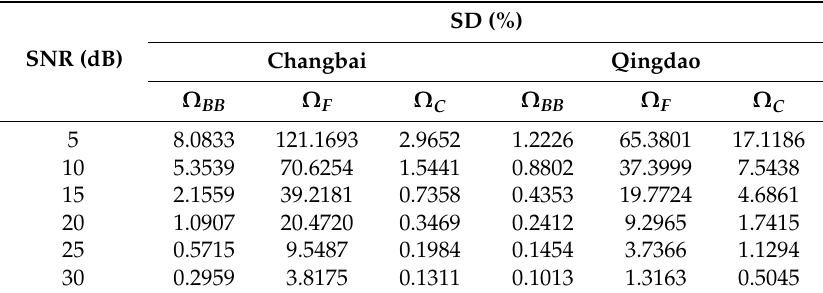
Table 3. SD ( σ SD ) under the condition of system